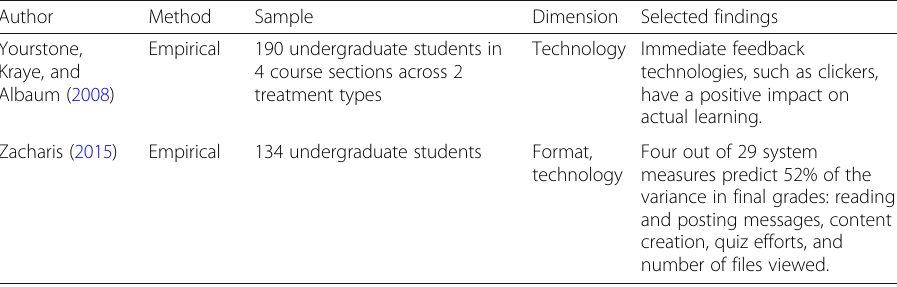
Table 1 Overview of Findings from the Extant Literature (Continued)